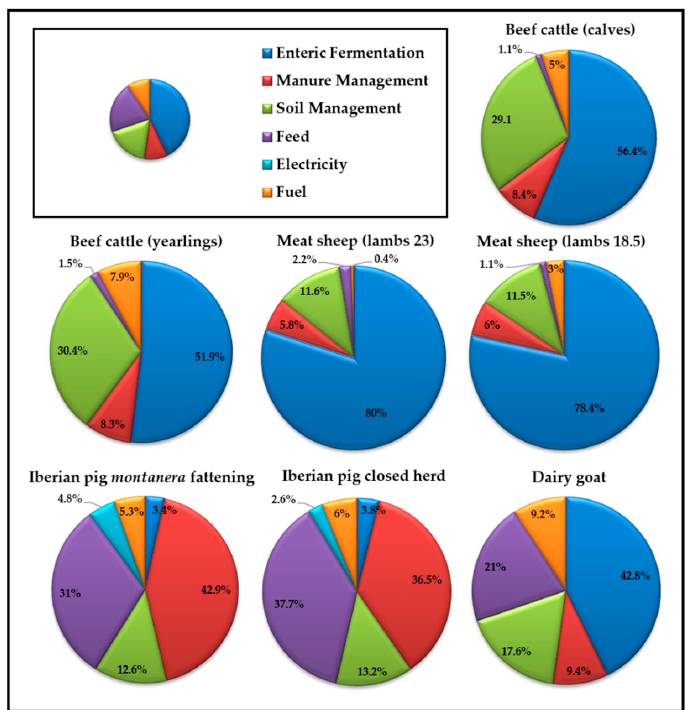
Figure 1. Importance of GHG emission levels by type of farm.